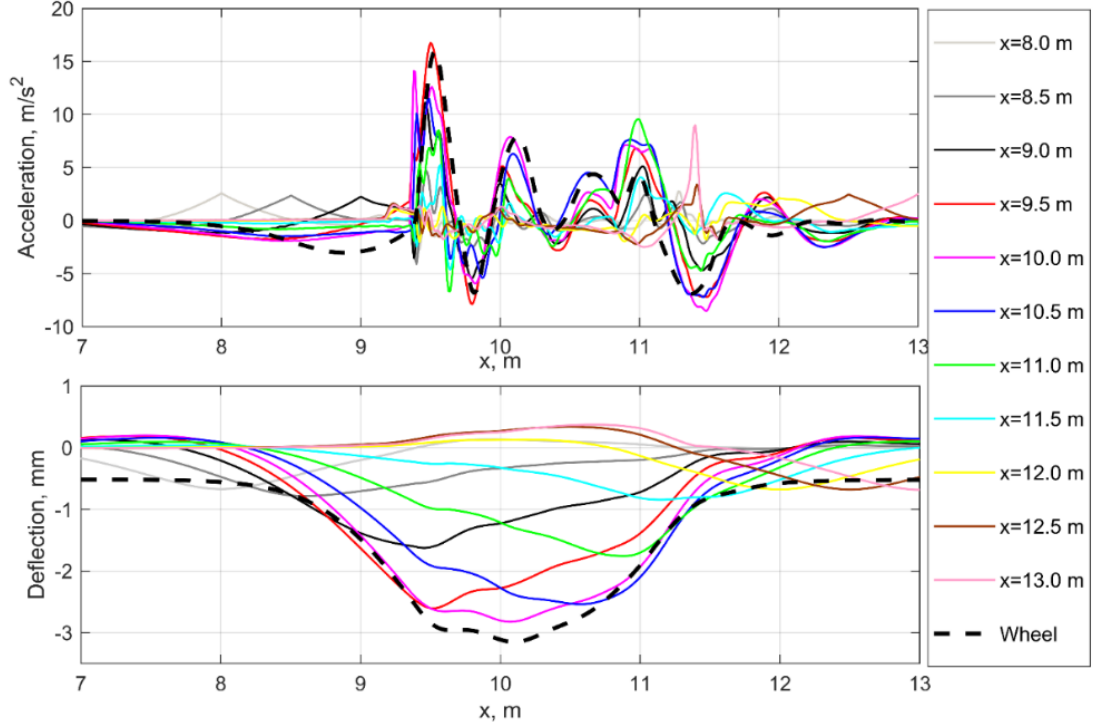
Figure 5. Simulated rail and wheel acceleration ( top ) and deflections ( bottom ) for the void irregularity.